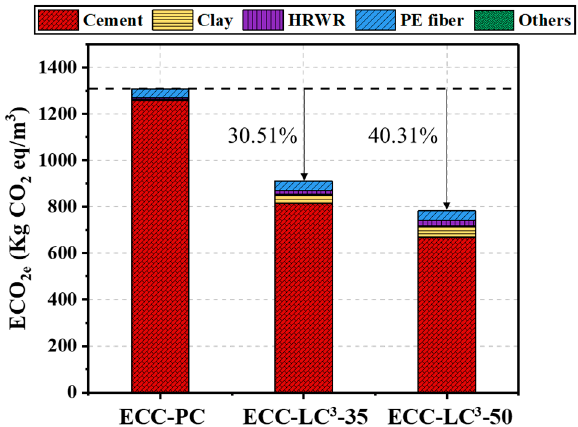
Figure 16. Summary of the GWP by each component of ECC.